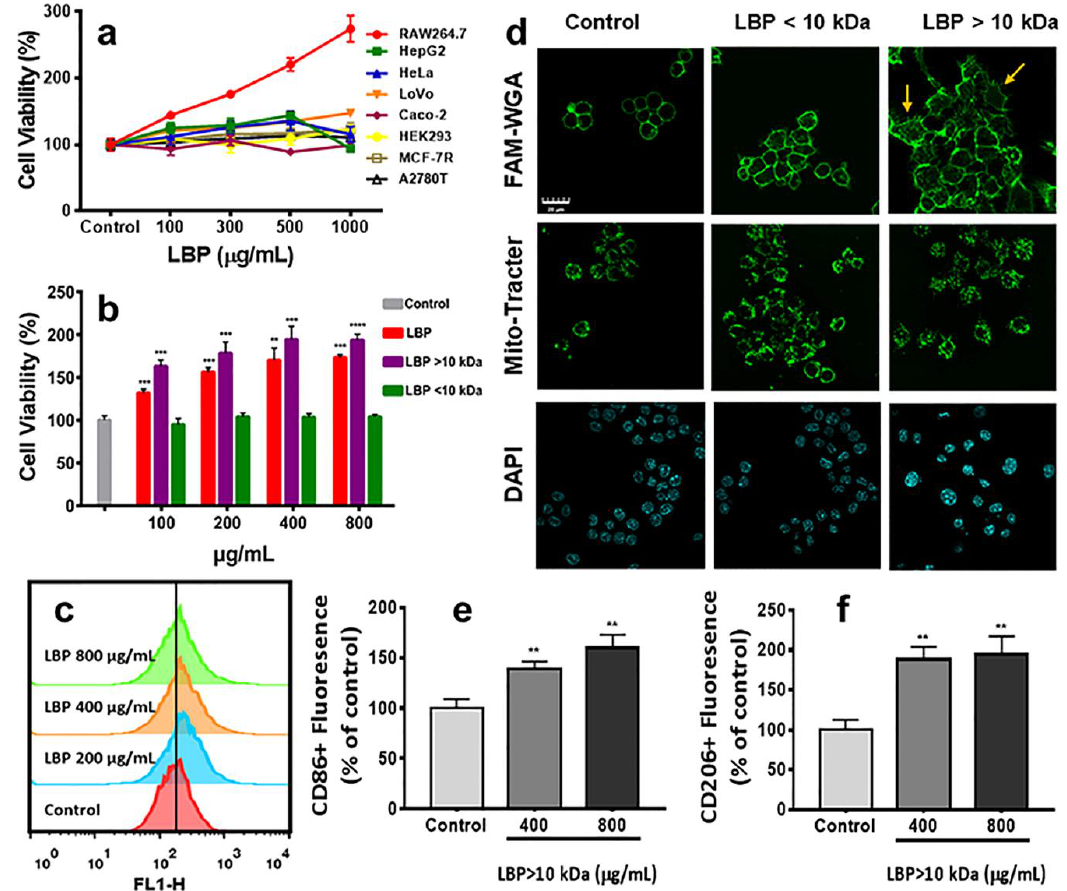
Figure 2. ( a ) Cell viability assay of di ff erent cell lines following the addition of LBP for 48 h; ( b ) cell viability assay of RAW264.7 cells treated with LBP, LBP < 10 kDa and LBP > 10 kDa for 48 h; ( c ) flow cytometry assay of CFSE distribution for investigating the e ff ect of LBP on cell division (RAW264.7); ( d ) E ff ect of LBP < 10 kDa and LBP > 10 kDa on the morphology of macrophages, the yellow arrows indicate filopodia (scale bar, 20 µ m); ( e ) Percentage of CD86 + RAW264.7 cells measured by flow cytometry after treatment by LBP > 10 kDa. ( f ) Percentage of CD206 + RAW264.7 cells measured by flow cytometry after treated by LBP > 10 kDa. Results were expressed as means ± SD, n = 3. * p <